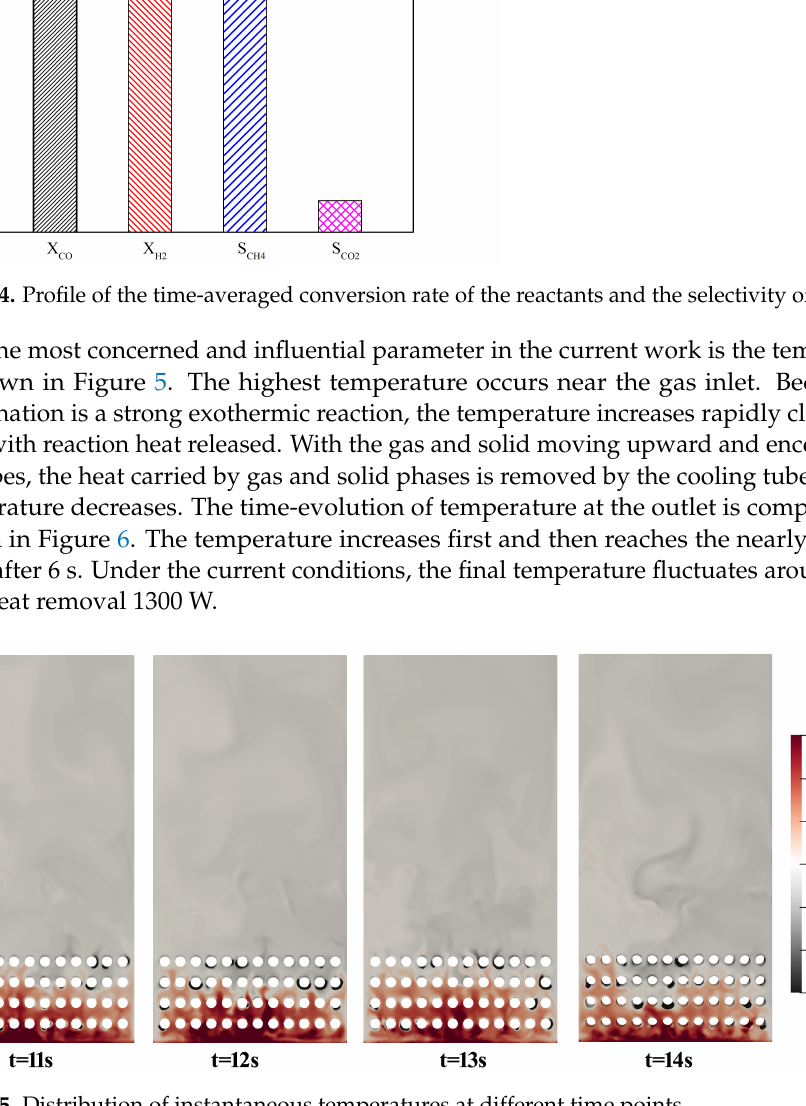
Figure 5. Distribution of instantaneous temperatures at different time